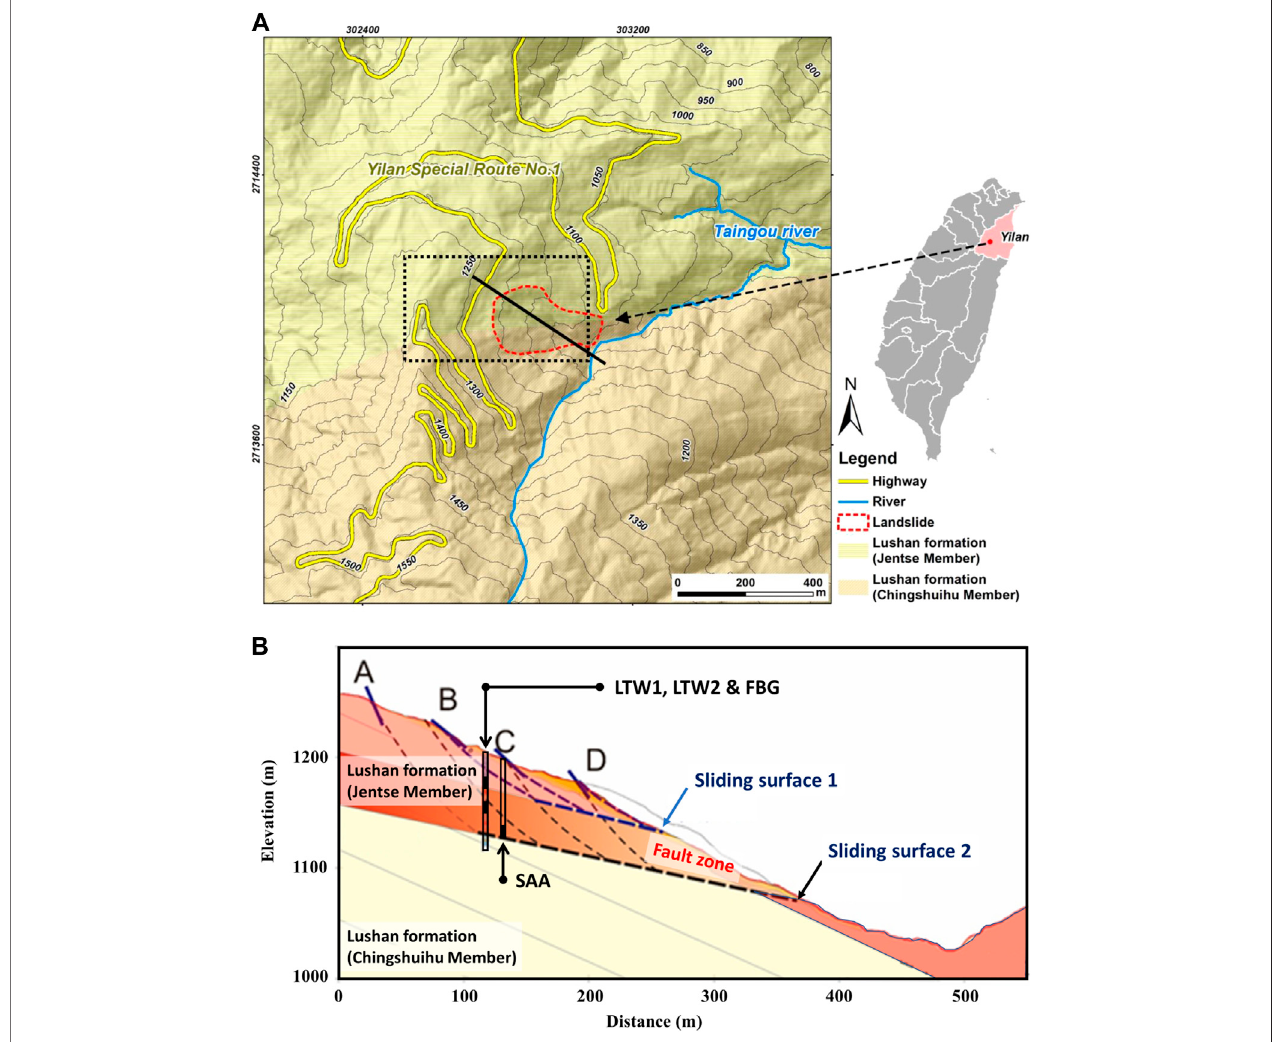
FIGURE 2 | Geological map (A) , together with a geological cross-section (B) , in the Lantai area, Yilan Taiping Mountain, Northeast Taiwan. A-D was identi fi ed as four landslide scarps. The black line in the geological map denotes the location of the geological cross-section and the dotted rectangle shows the area in Figure 1 .